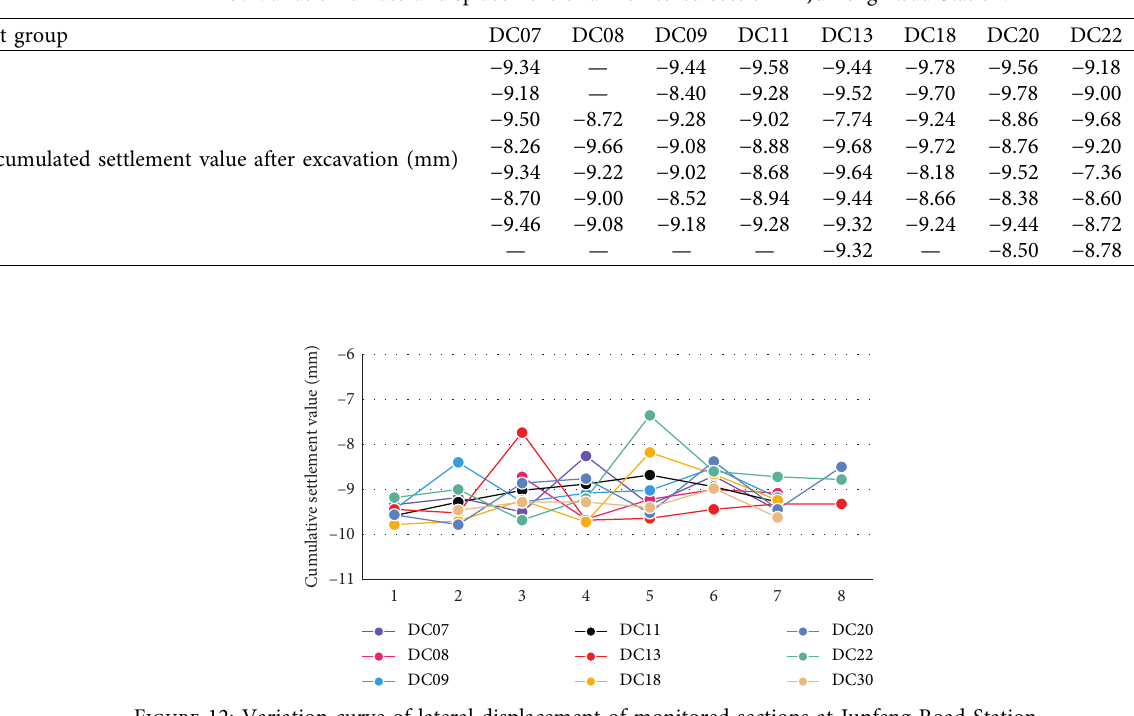
Table 9: Variation of lateral displacement of a monitored section in Junfeng Road Station.